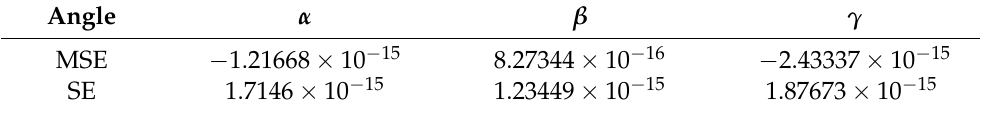
Table 12. Mean Squared Error (MSE) and Standard Error (SE) of the Orientation—Second Case.